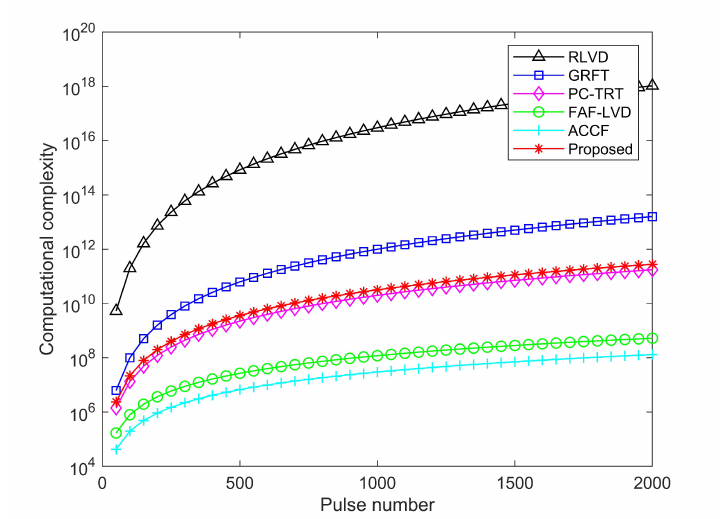
Figure 5. Computational complexity